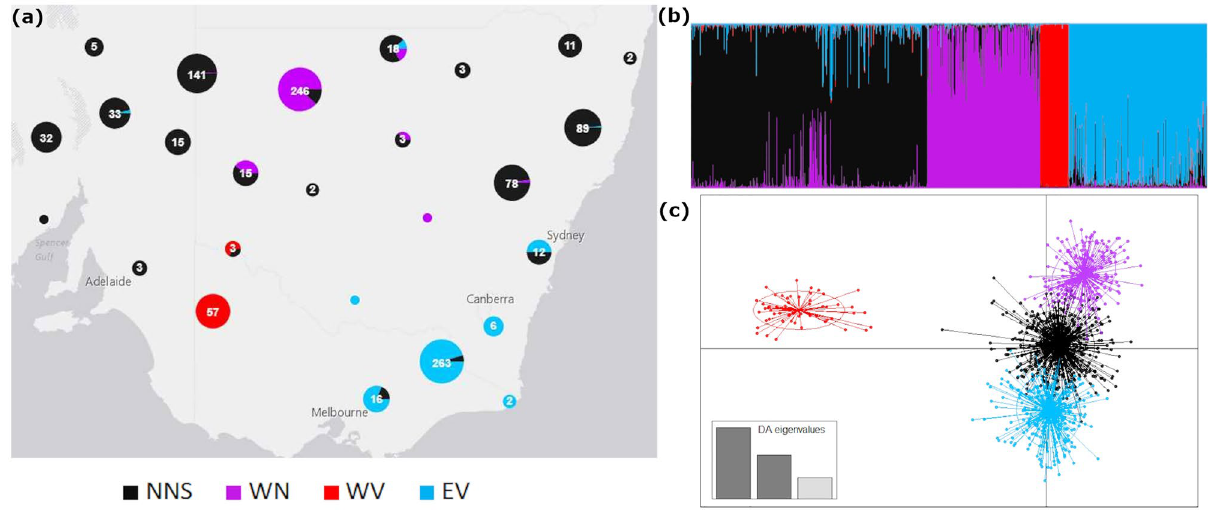
Figure 2. STRU CTU RE and DAPC analyses of 1058 free-ranging dogs showing four clusters and genetic isolation of the WV population. Populations are coloured according to location: NNS Northern New South Wales and South Australia, WN Western New South Wales, WV Western Victoria and EV Eastern Victoria. ( a ) Results of STRU CTU RE analysis, circles represent the proportion of assignment of each genotype to each cluster combined per location to better visualise samples collected at the same site. Numbers in white are the number of samples represented within each pie chart, which is also represented by the size of each chart ( b ) Bar plot of STRU CTU RE results, each vertical line represents an individual coloured by the proportion of their genotype assigned to each cluster. ( c ) DAPC scatterplot of clusters showing isolation of the WV population. Eigenvalues for the discriminant analysis are presented in the bottom left of the plot.